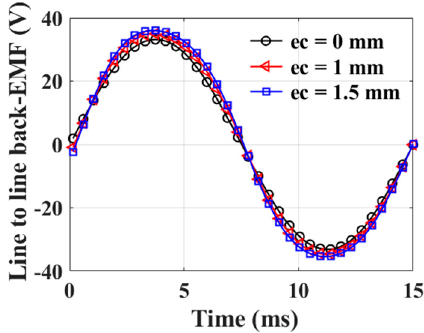
Figure 4. One-phase back electromotive force (EMF) based on rotor eccentricity ratio.